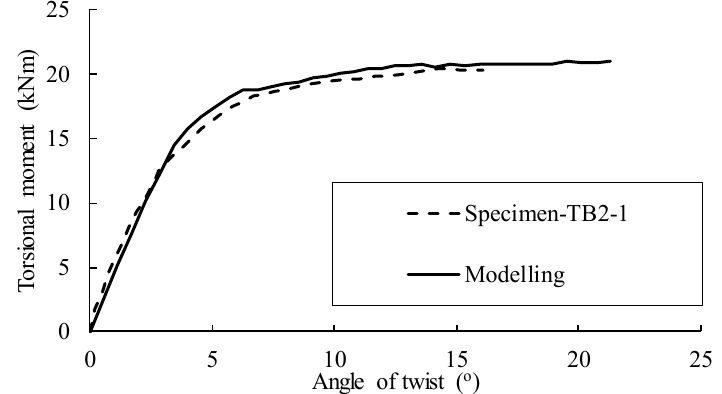
Figure 6. Comparing the numerical and experimental (adapted from [63]) results.